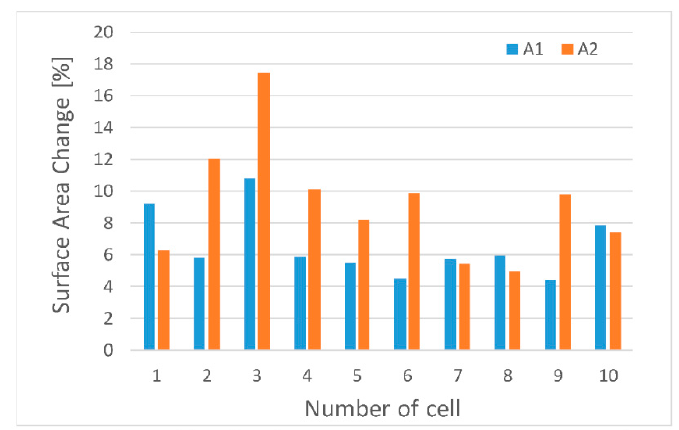
Figure 4. Dependence of the different cells’ diameters change during porcine oocyte deformation; microscopic images of the selected cells, prior the deformation, are also showed.